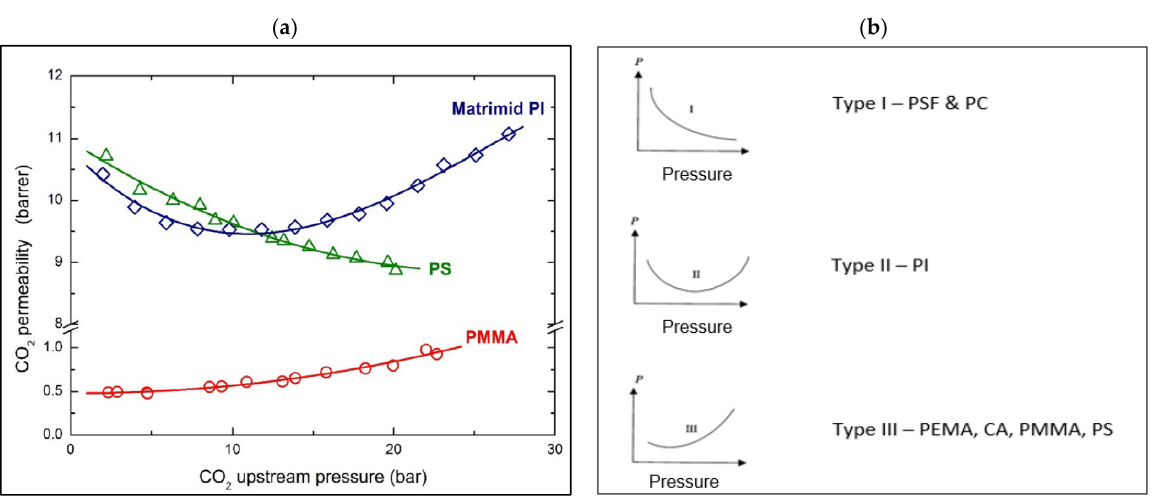
Figure 5. ( a ) CO 2 permeability in three different glassy polymers at 35 °C vs. pressure [60]. ( b ) Illus- tration of permeabilities (P) for some glassy polymers to CO 2 up to 30 bar [65]. The different trends were due to the difference in Tg, thickness, molecular weight, free volume, permeability mechanism, and many other polymer characteristics [60]. Pol-